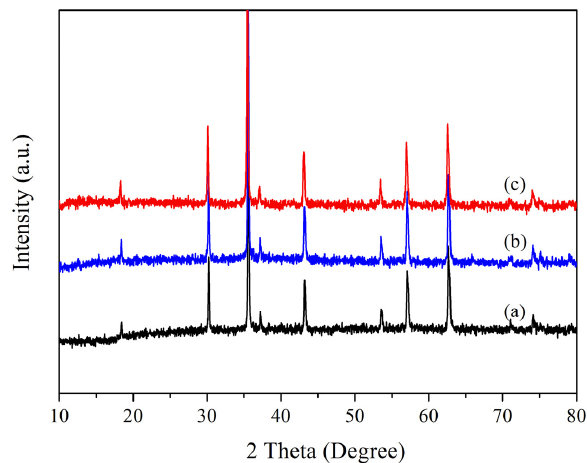
Figure 2. Powder X ‐ ray diffraction (PXRD) patterns of the Fe 3 O 4 nanoparticles ( a ); polydopamine-coated Fe 3 O 4 nanoparticles ( b ); and the immobilized enzyme ( c ).